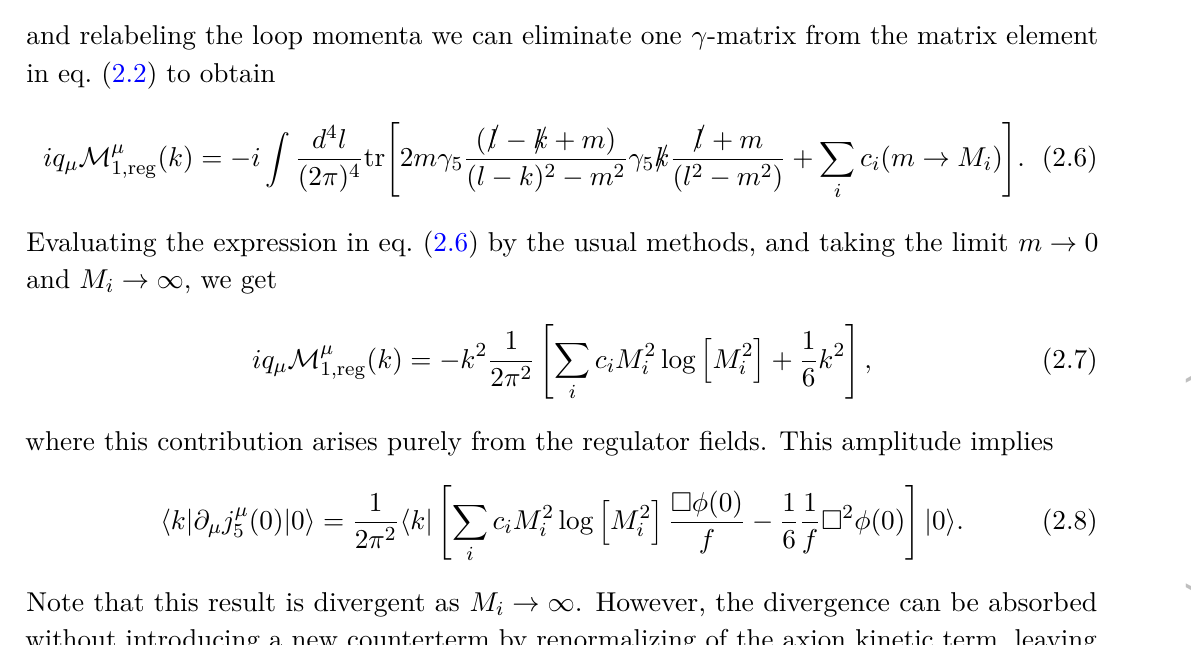
Figure 2 . Feynman rule for pseudoscalar-fermion interaction